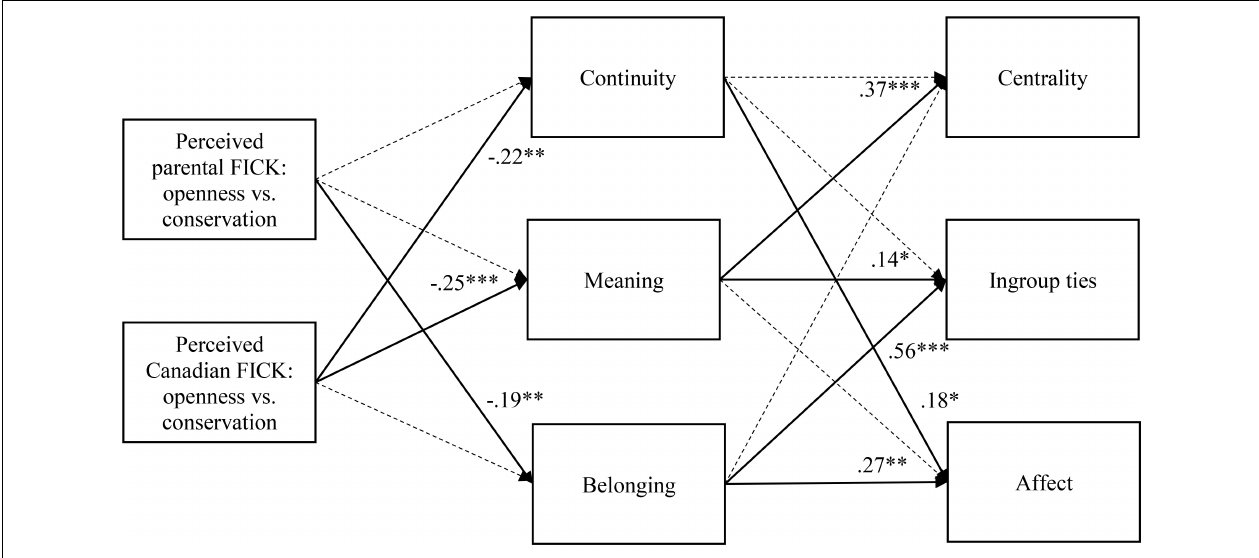
FIGURE 3 | The path model depicting how perceived parental and outgroup FICK in openness to change versus conservation affect Chinese identification via continuity, meaning, and belonging motives (Study 2). FICK, fit in cultural knowledge. Dashed lines represent non-significant paths that were removed from the final model. Solid lines represent statistically significant paths with numbers indicating standardized regression coefficients. ∗ p < 0.05, ∗∗ p < 0.01, ∗∗∗ p < 0.001.